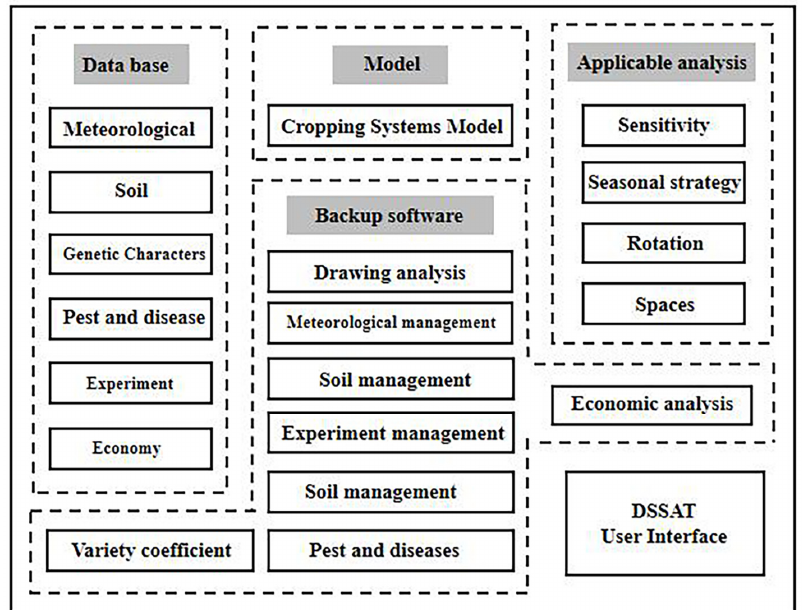
Figure 3. Diagram of database application and support software components of DSSAT.